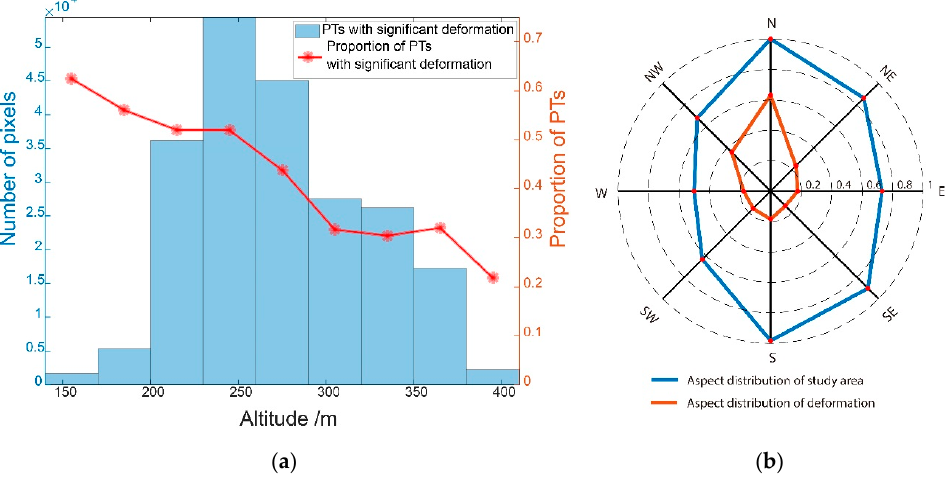
Figure 6. ( a ) significant deformation distribution at different altitudes. ( b ) aspect distribution of study area and deformation.